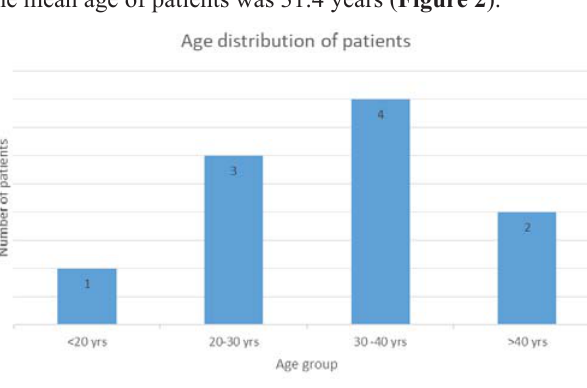
Figure 1. Sex distribution of patients 70% of the patients were aged between 20 and 40 years and the mean age of patients was 31.4 years ( Figure 2 ).